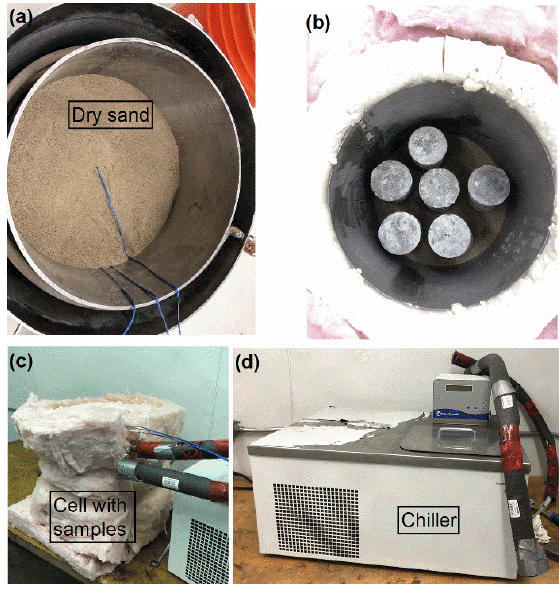
Figure 10. Temperature control system: ( a ) steel container where the samples were kept, ( b ) samples kept in the cell, ( c ) the cell containing samples and sand wrapped for insulation, and ( d ) chiller used to conduct the heat transfer.